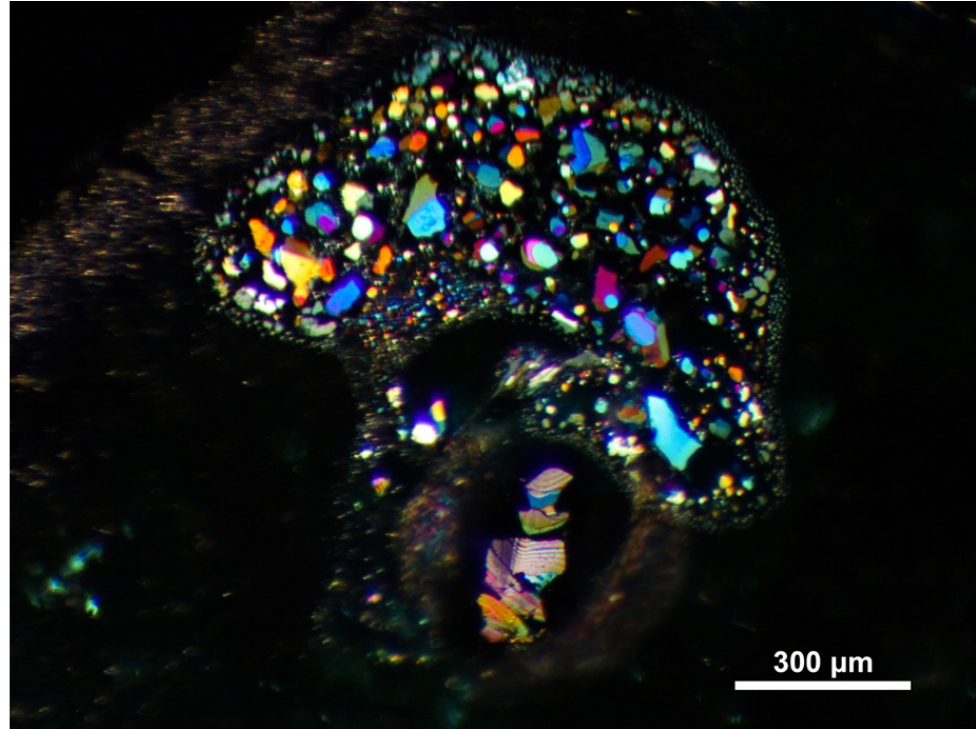
Figure 19. The thin film consists of minute voids that show distinct interference color under micro- scopic observation.